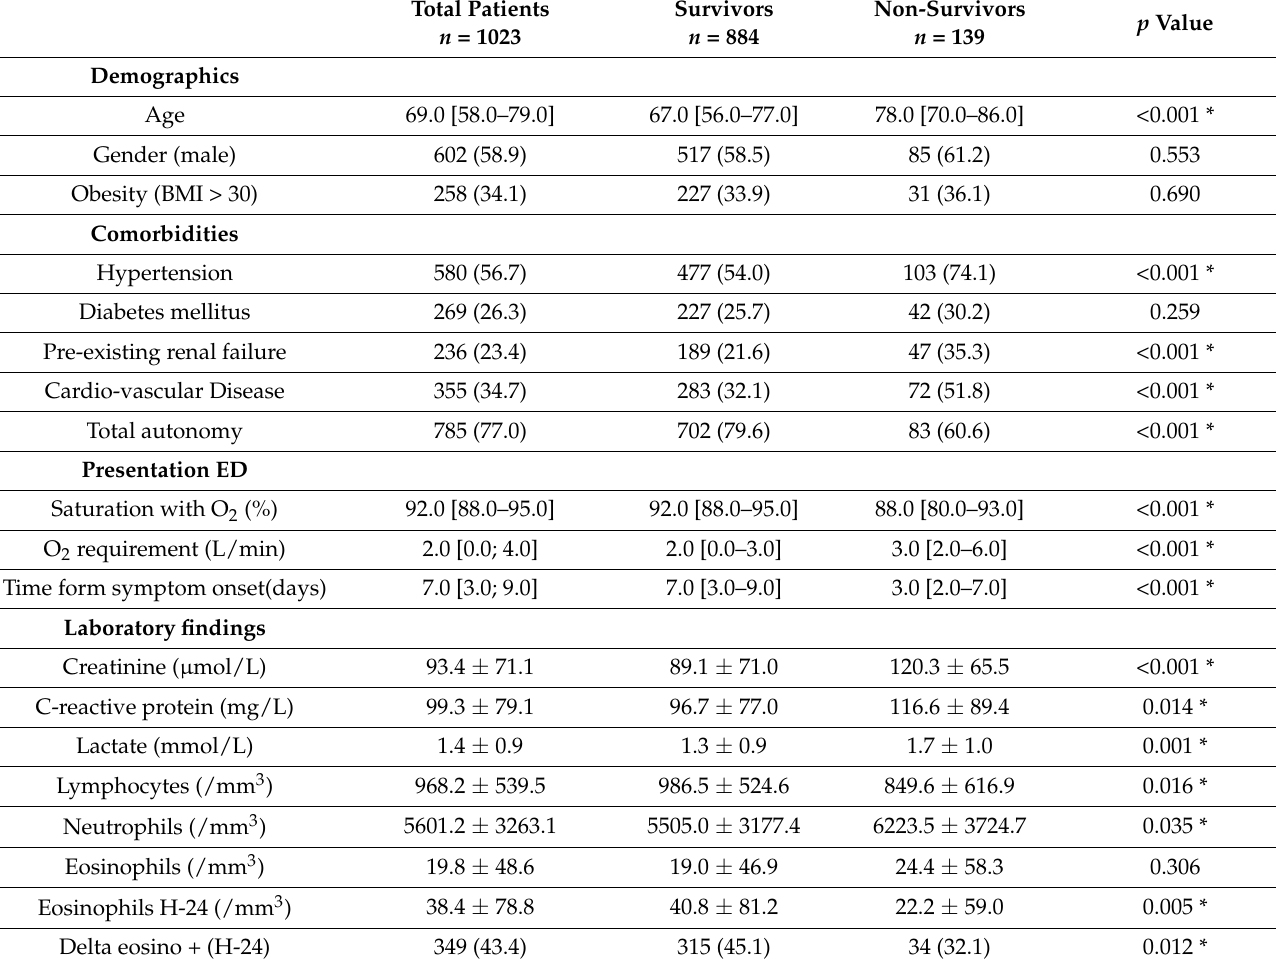
Table 3. Overall characteristics of patients with SARS-CoV-2 and comparison according to